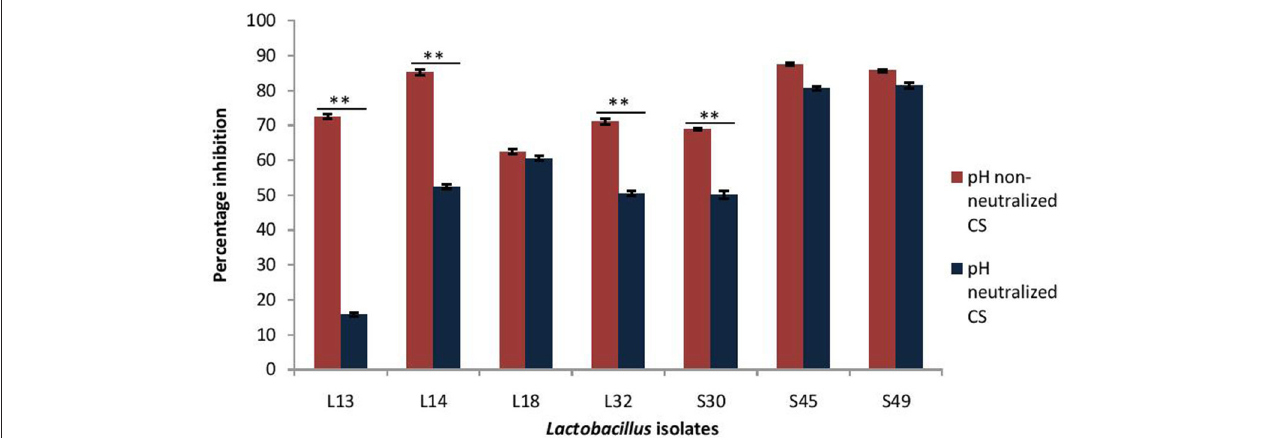
FIGURE 4 | Percentage dispersion of pre-formed biofilm of V. cholerae by pH neutralized and non-neutralized CS of fecal Lactobacillus isolates evaluated by modified crystal violet assay performed in a microtiter plate. Bars are representative of the mean and error bars are representative of the standard deviation of three